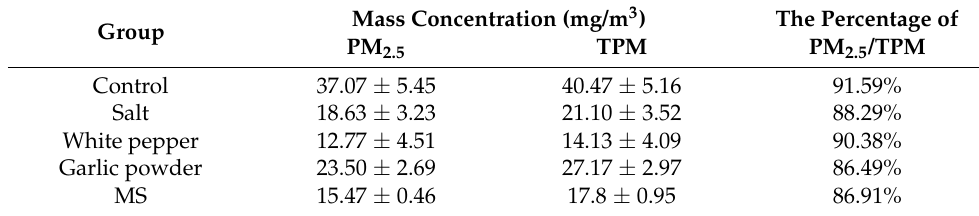
Table 4. The percentage of PM 2.5 to total particles concentration emitted from the